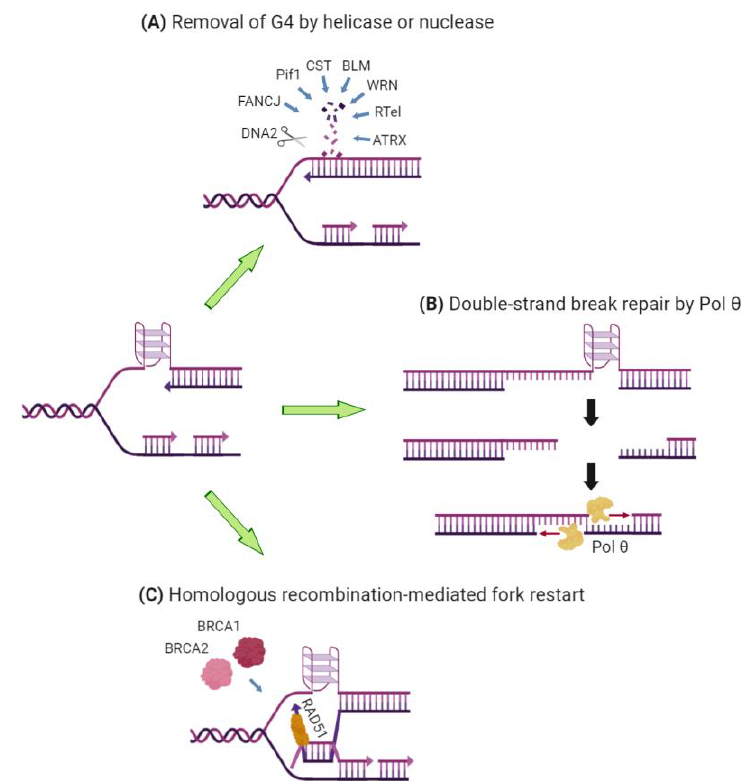
Figure 1. Cellular strategies to minimize genomic damage arising from G-quadruplex (G4)-mediated replication stalling. ( A ) A large number of helicases and nucleases exist to remove G-quadruplexes; it is not yet clear why so many proteins with this function are needed. ( B ) In the absence of FANCJ, deletions occur in the region surrounding G-quadruplexes. The size of these deletions is kept in check by the end-joining and gap-filling activity of polymerase θ [16]. ( C ) In the absence of Pif1, homologous recombination mediated by RAD51, BRCA1, and BRCA2 can lead to genomic rearrangements [20]. Figure created with BioRender.com.